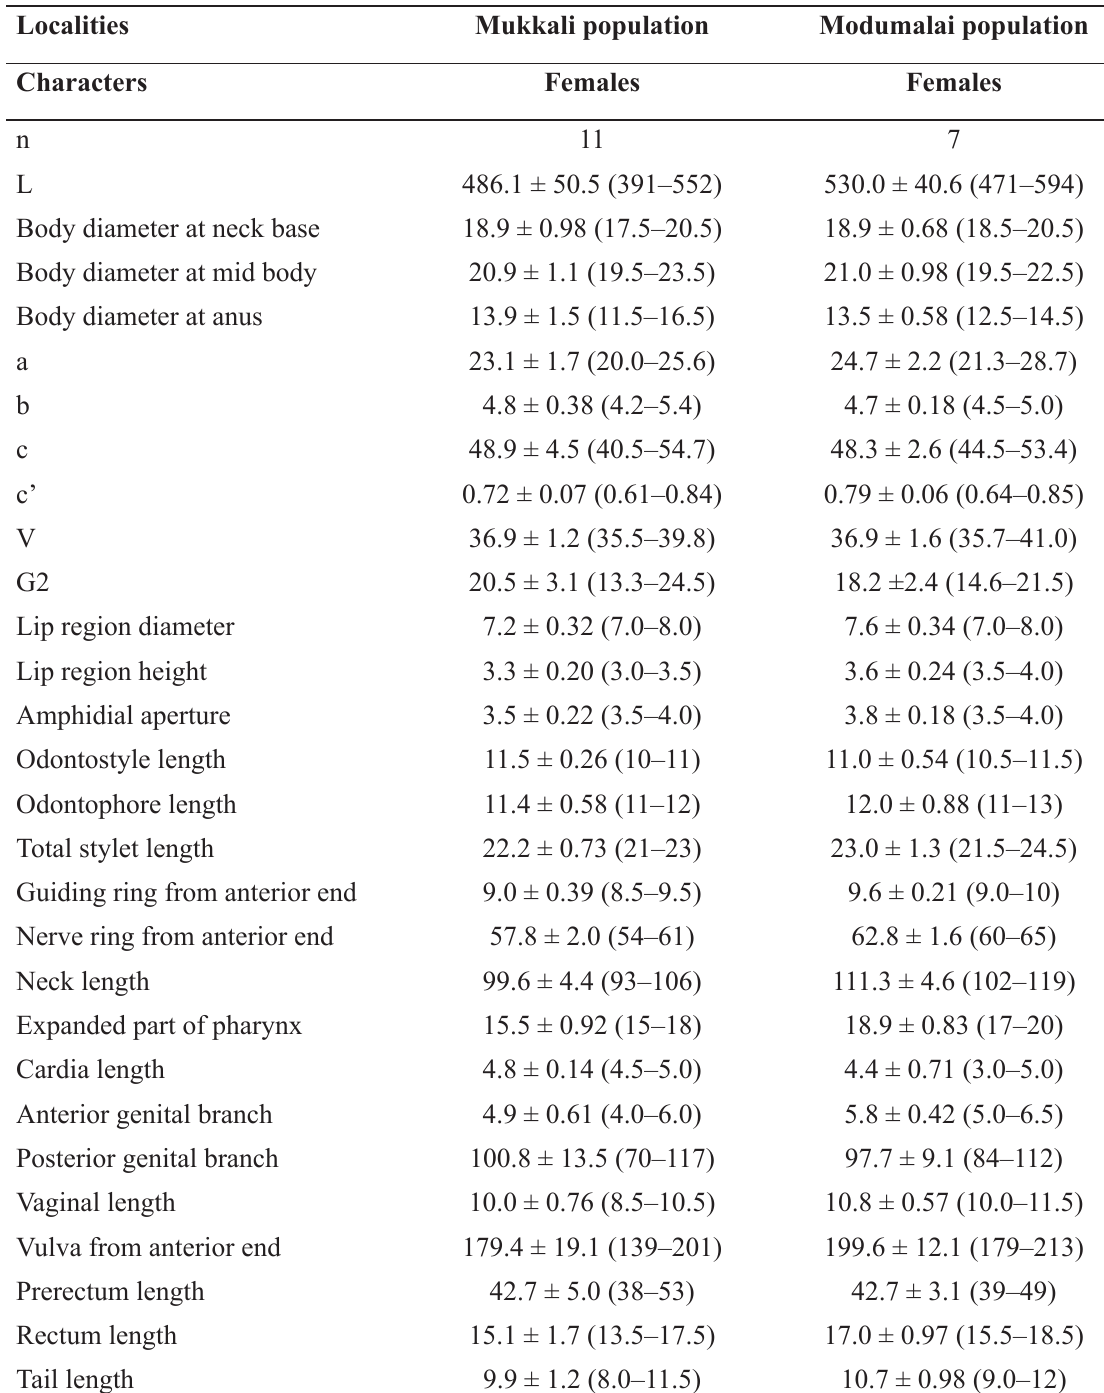
Table 5. Measurements of Basirotyleptus acus Goseco, Ferris & Ferris, 1974. All measurements are in μm and in the form: mean ± s.d.